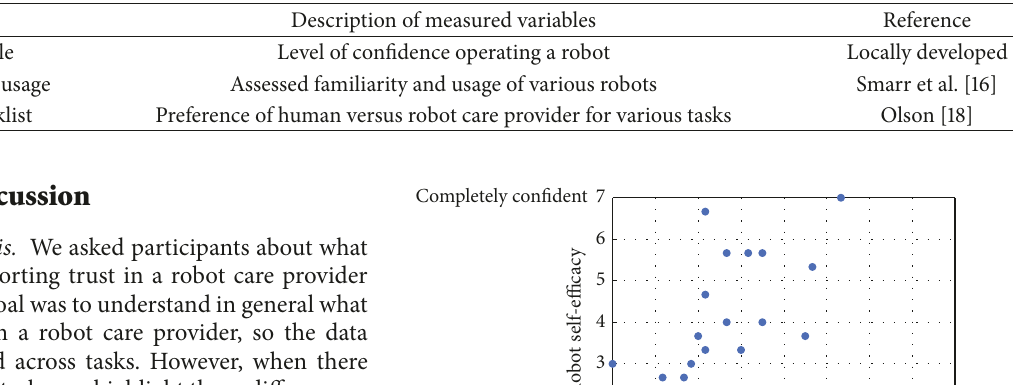
Table 4: Postinterview questionnaires.